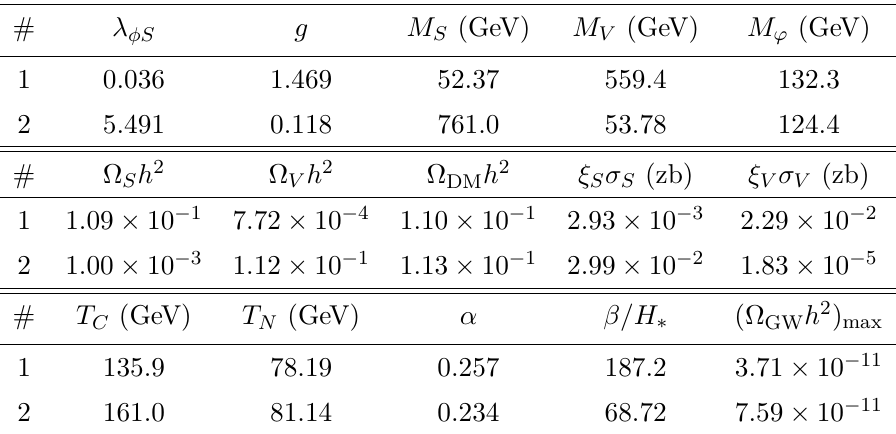
Table 1. Two benchmark points with DM and phase transition parameters.